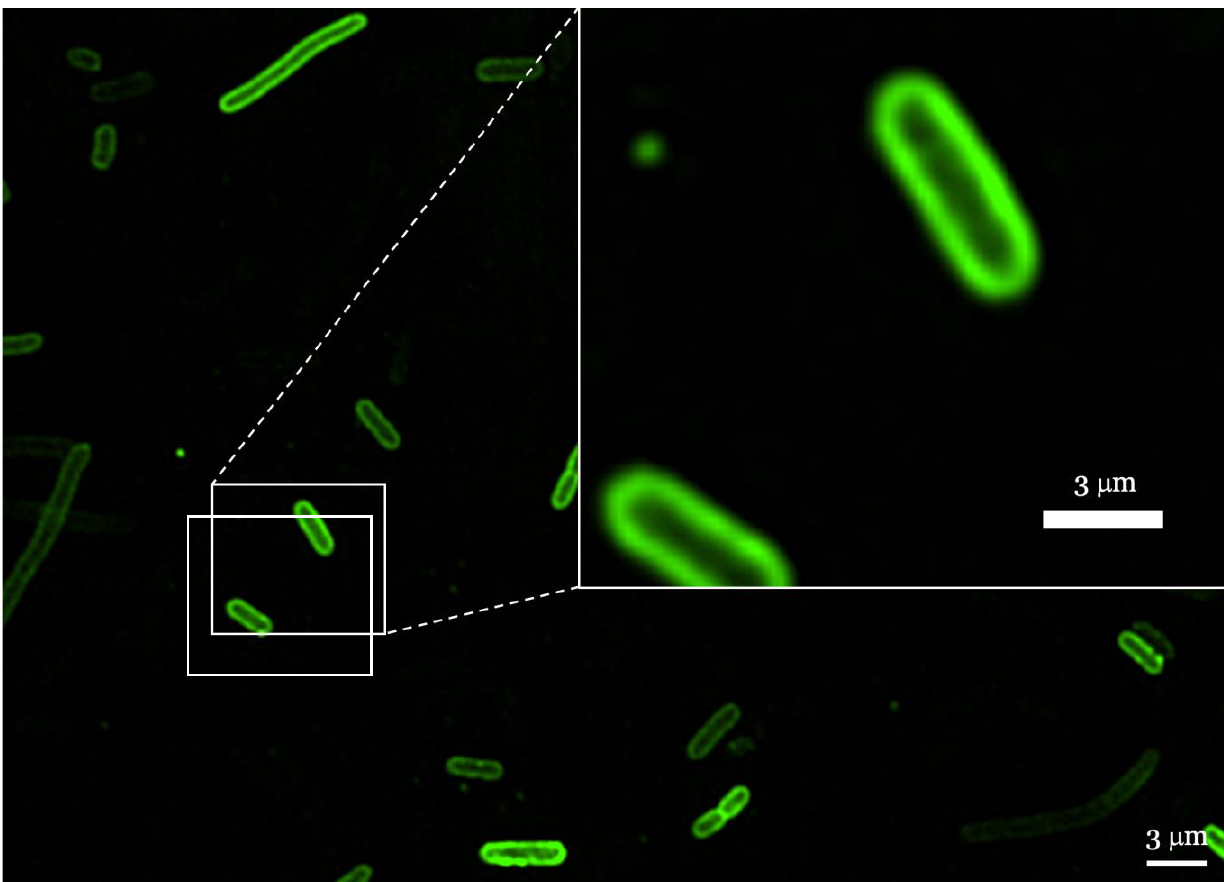
Figure 5. Localization of FITC-labeled RP556 peptide in E. coli cells imaged by confocal microscopy. The image is also representative for R1 and R10 peptides.